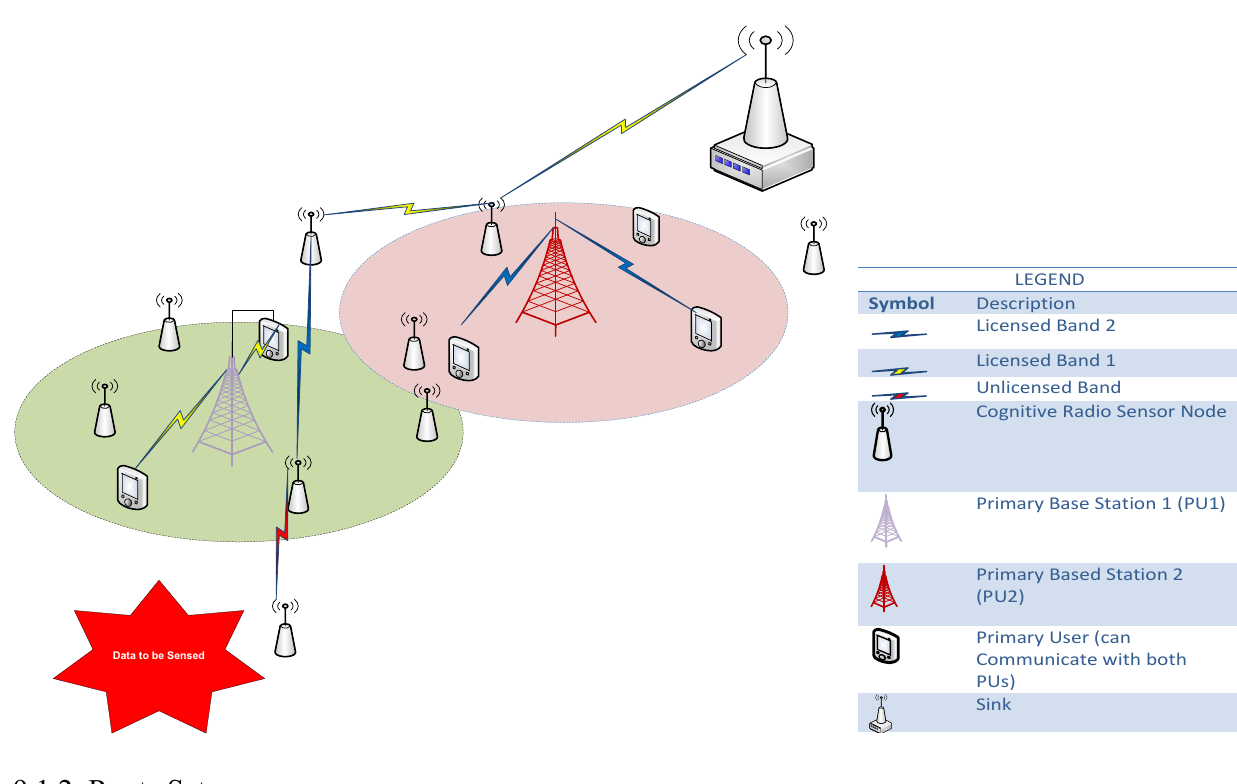
Figure 9. Illustration of a typical routing scenario in a